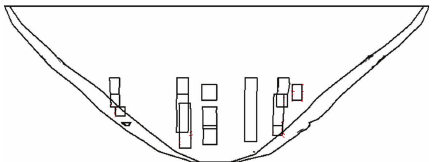
Figure 16: Distribution of cracks unbalanced force under overload 2.0𝑃 0 in scheme 1.